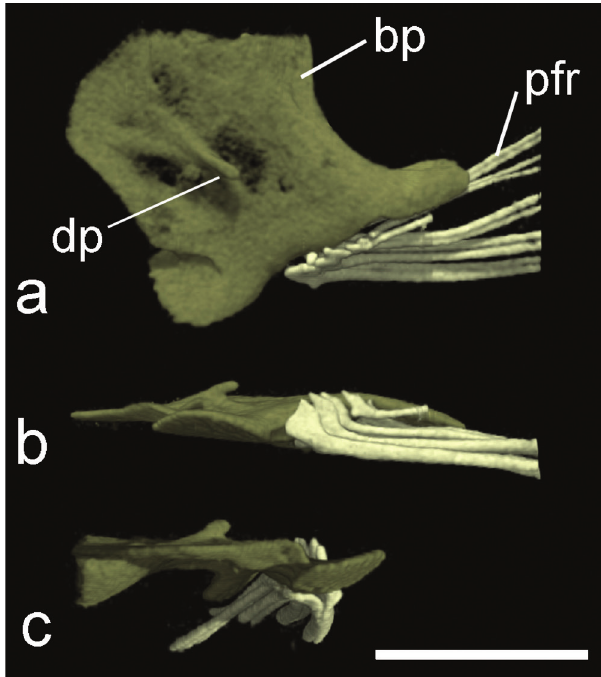
Fig. 10. HRXCT model of pelvic girdle of Hoplomyzon cardosoi , MCNG 375, holotype, 18.5 mm SL. a. Dorsal view; b. lateral view and c. frontal view. bp: basipterygium; dp: dorsal process of basipterygium; pfr: pelvic-fin rays. Scale bar = 1